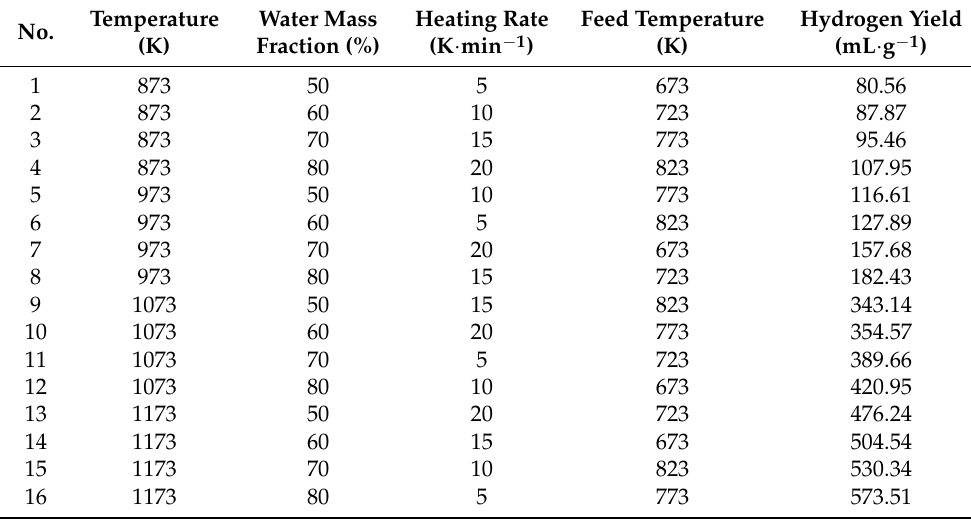
Table 3. Orthogonal experimental scheme and results.